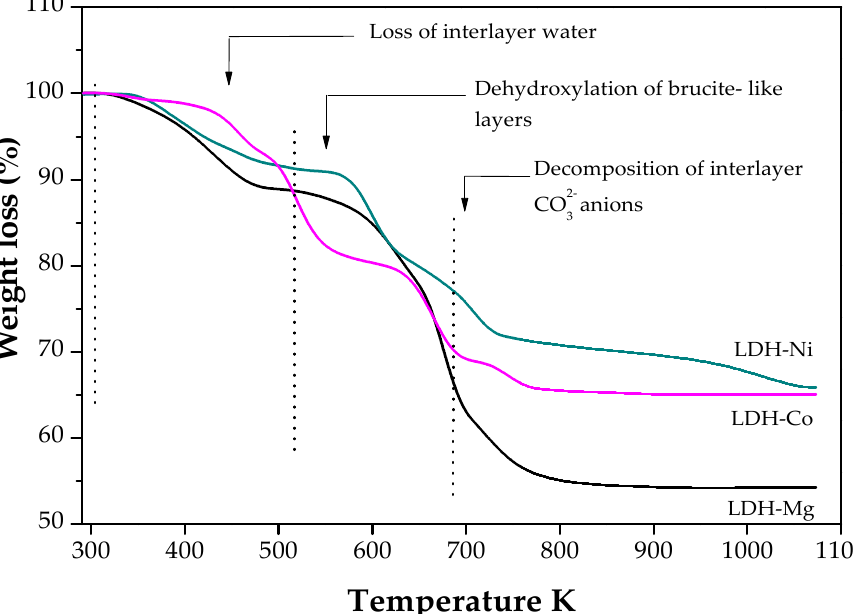
Figure 4. Thermogravimetric analysis of LDH.